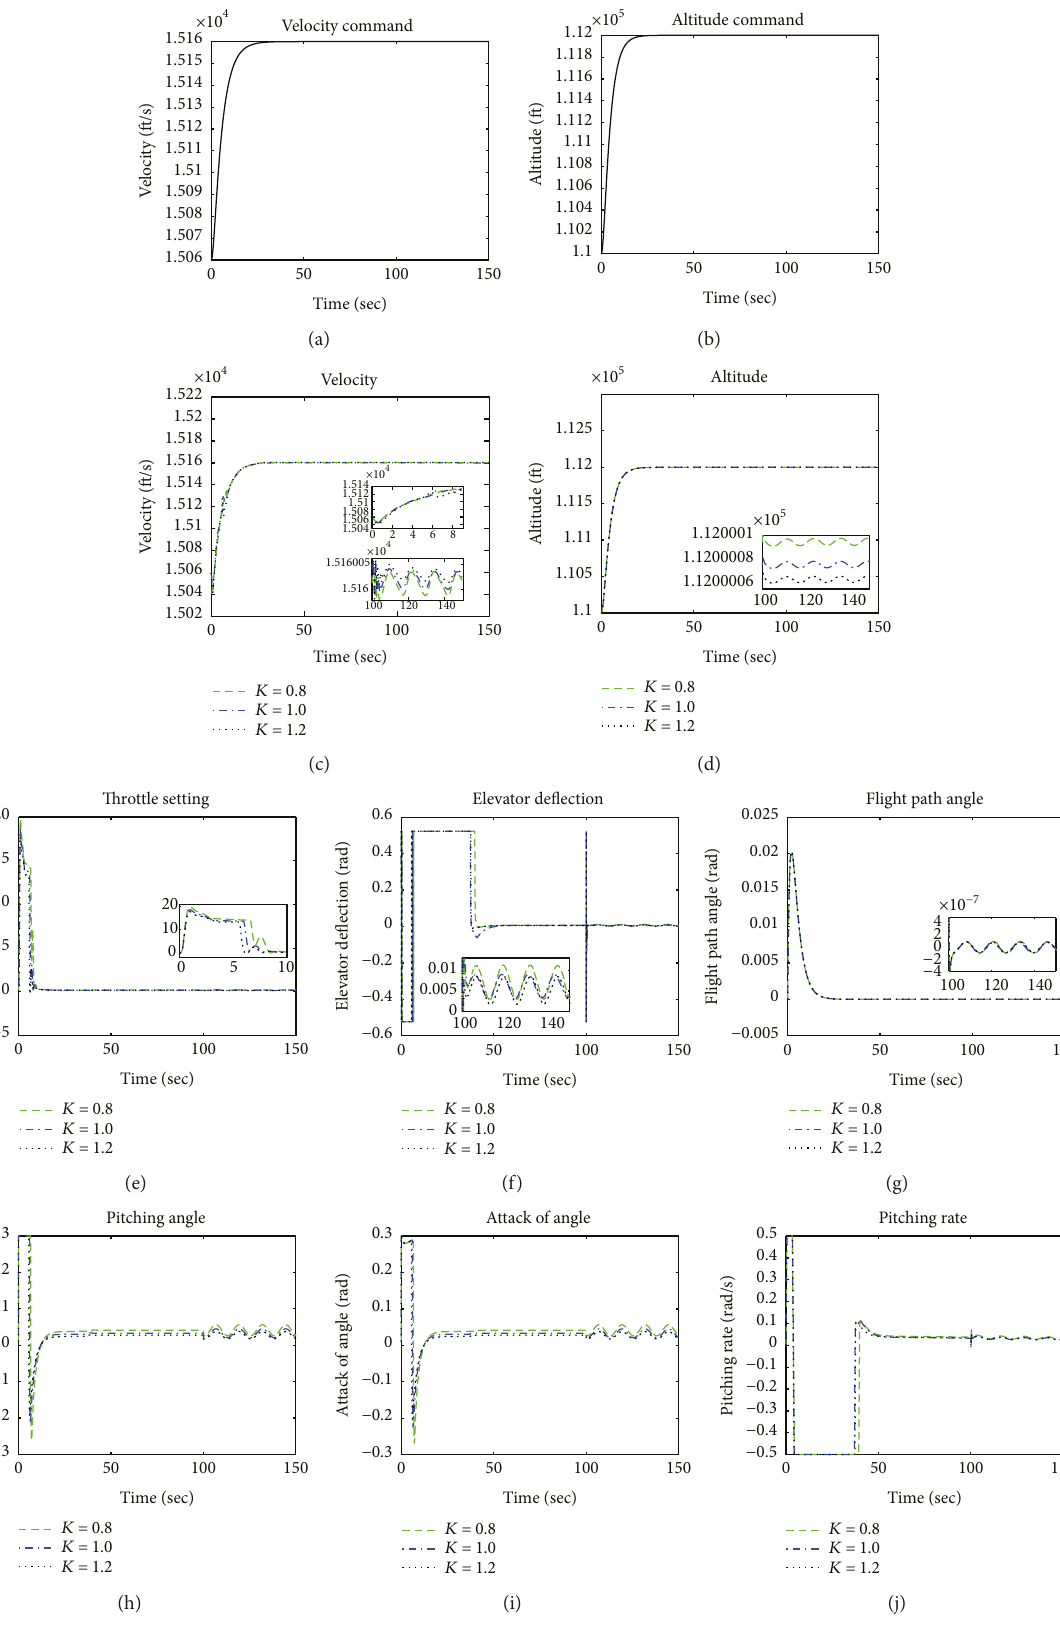
Figure 9: Altitude command, response, and controller. The uncertainty terms and external disturbance are added into the